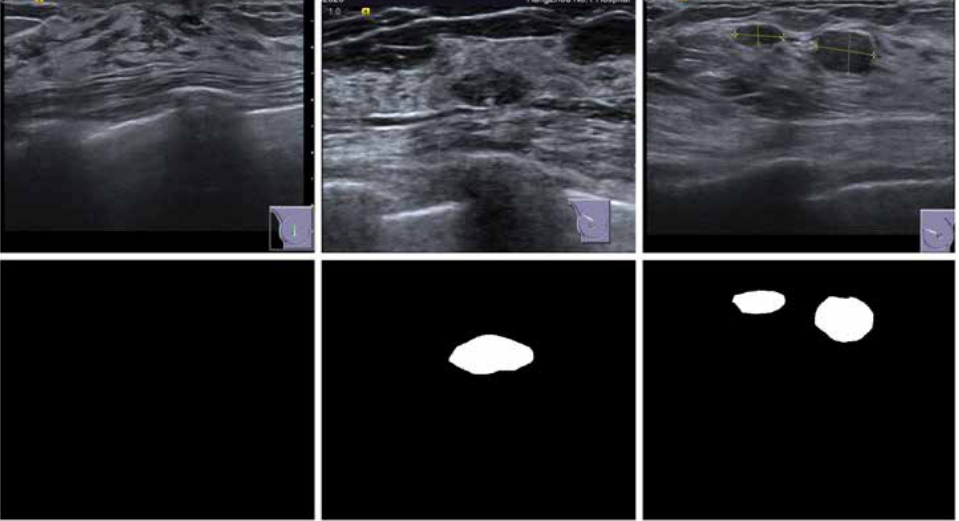
Figure 3 Typical sub-images of breast nodule(s) and normal breast (top), and the corresponding binary masks (bottom) used for training the convolutional neural